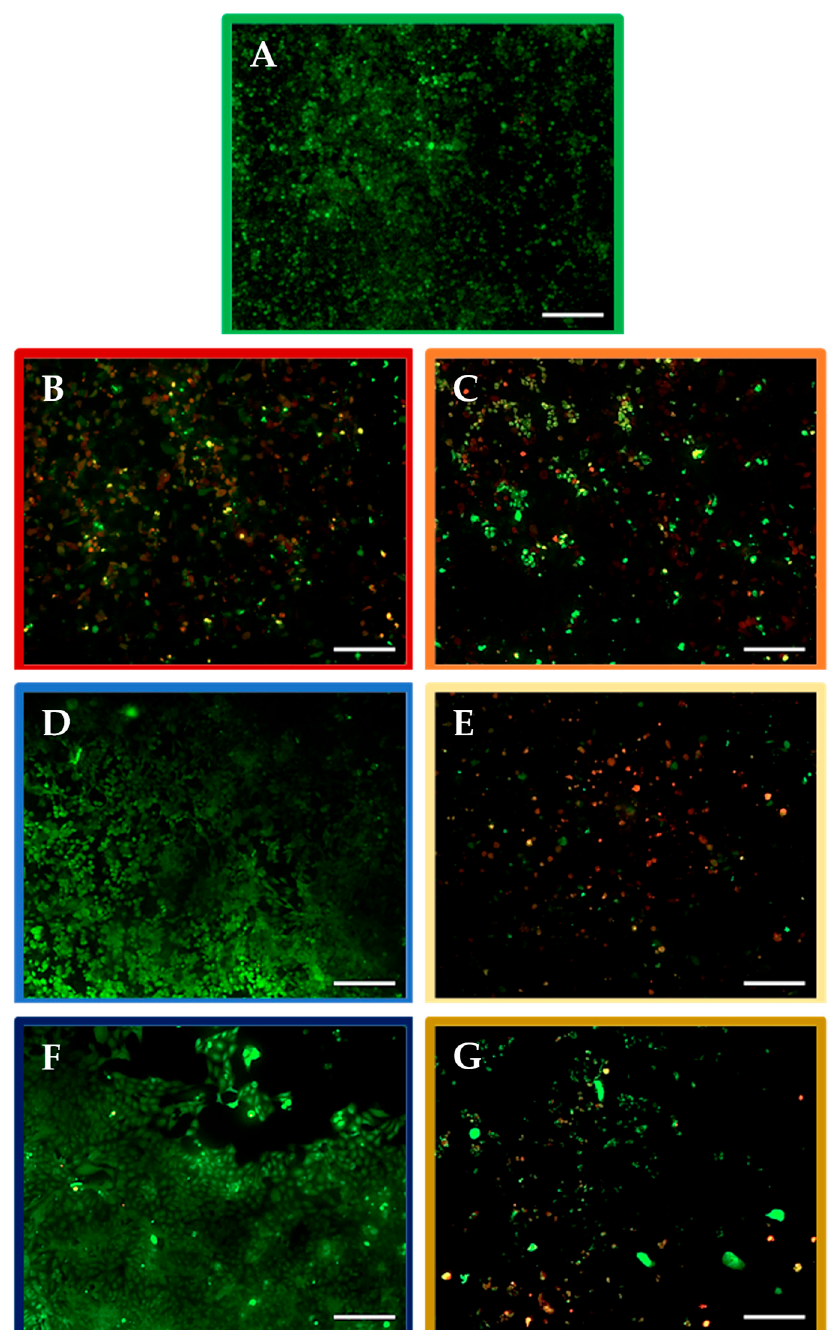
Figure 4. Images of live/dead assays conducted using breast cancer MCF7 cell monolayers after 48 h exposure to nurP28 peptide alone and in combination with DTX. ( A ) 10 µM DTX; ( B ) 1 µM DTX; ( C ) 3 ng/mL nurP28; (D) 3 ng/mL nurP28 + 1 µM DTX; ( E ) 300 ng/mL nurP28; ( F ) 300 ng/mL nurP28 + 1 µM DTX; and ( G ) untreated cells (vehicle control). Viable cells appear green and those with compromised metabolic activity appear orange/red. Magnification: 10×. Scale bar: 200 µM.